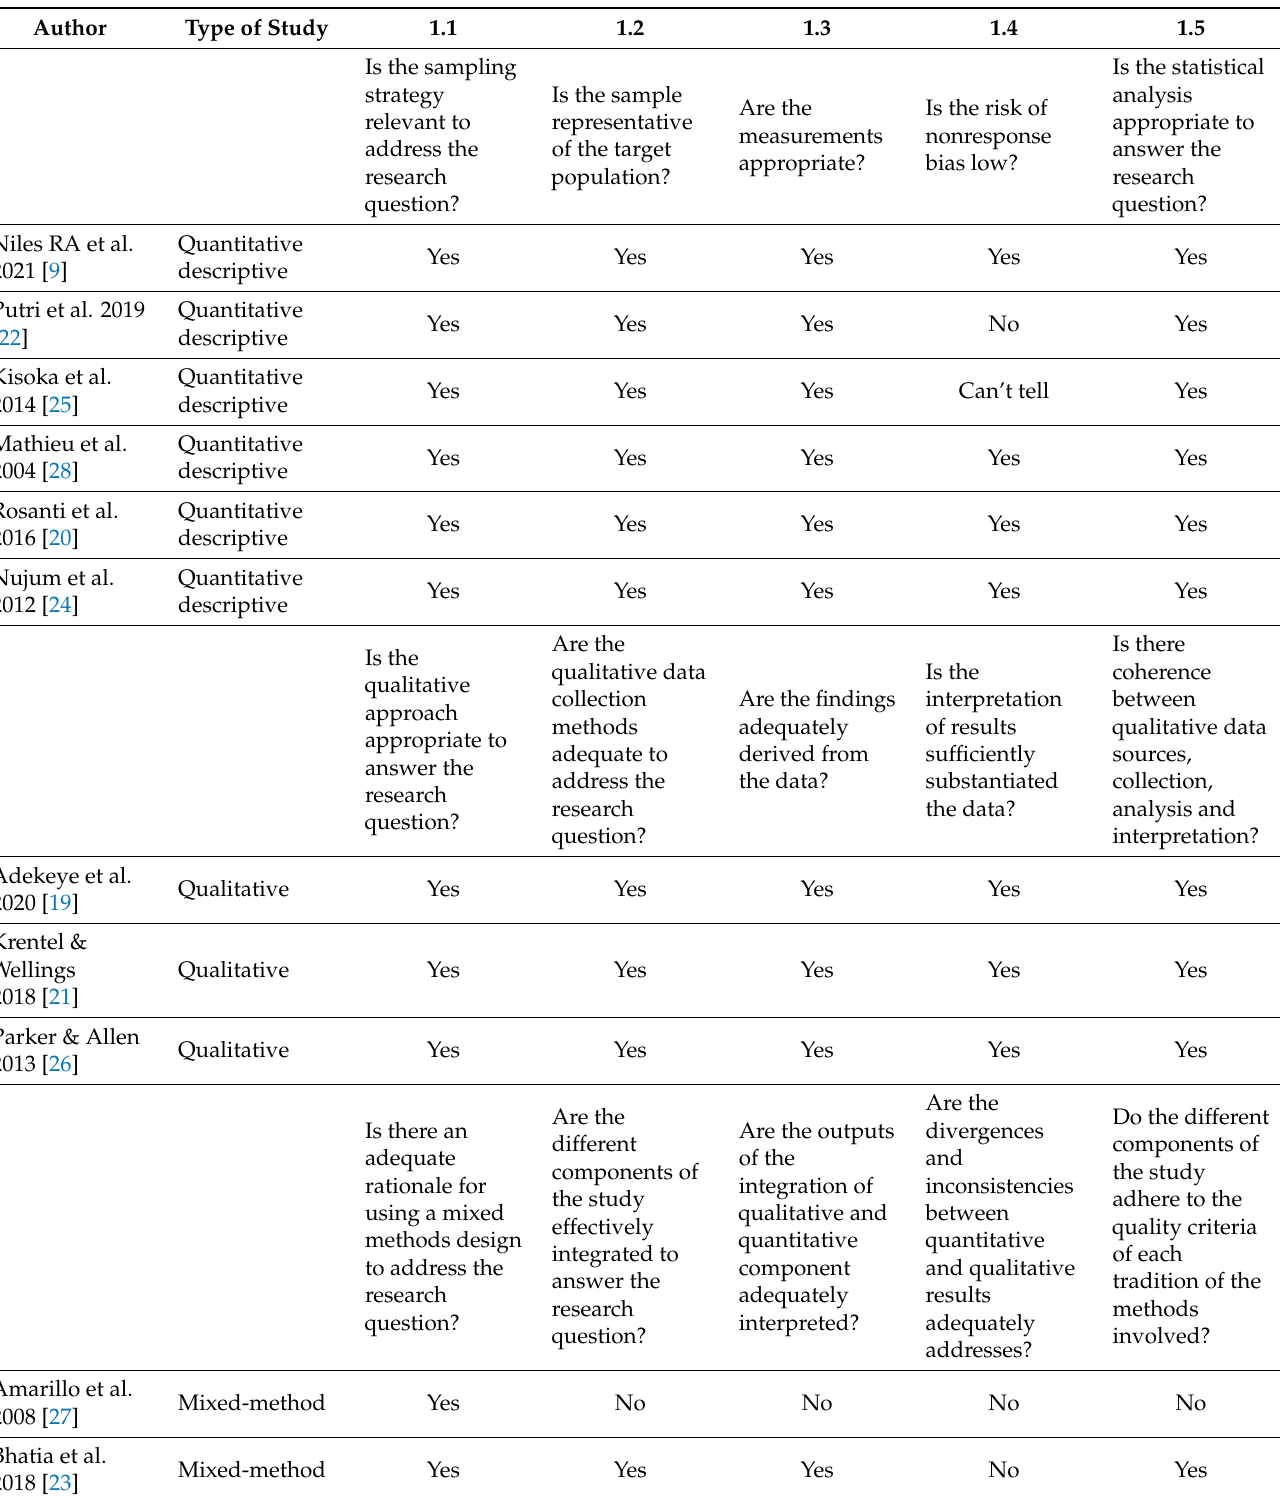
Table 3. The details of the MMAT